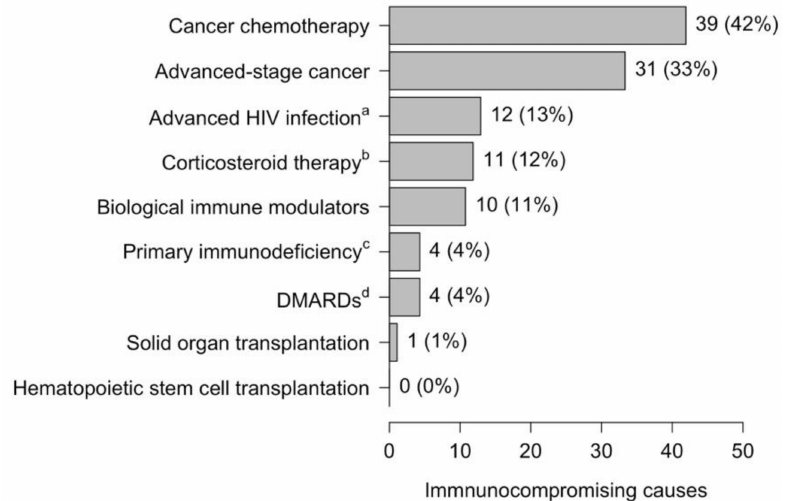
Figure 1. Causes of immunocompromising condition among patients hospitalized with